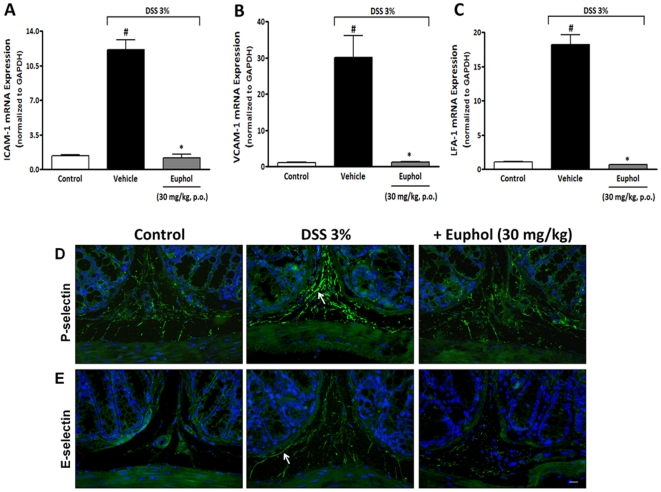
Preventive treatment with euphol blocks integrins and selectins expression in the colonic tissue after DSS-induced colitis.At the end of 7 days, colon tissue was collected and processed for mRNA expression and immunofluorescence. Preventive treatment with euphol (30 mg/kg, p.o.) reduced colonic mRNA expression of inter-cellular adhesion molecule 1 (ICAM-1) (A), vascular cell adhesion molecule-1 (VCAM-1) (B) and lymphocyte function-associated antigen 1 (LFA-1) (C). The real-time PCR assay was performed in duplicate and GAPDH mRNA was used to normalize the relative amount of mRNA. The same scheme of treatment with euphol also impaired the increase of P-selectin (D) and E-selectin (E). Representative images of P-selectin and E-selectin immunofluorescent stains were obtained on day 7 from control healthy mice, DSS-treated group and euphol (30 mg/kg, p.o.) treated group. Nuclei were stained with Hoechst (0.5 µl/ml). Scale bar corresponds to 50 µm and applies throughout. Data are reported as means ± S.E.M. of 8 to 10 mice per group and is representative of three independent experiments. #P<0.05 vs. control healthy group (non colitic); *P<0.05 vs. DSS-treated group.